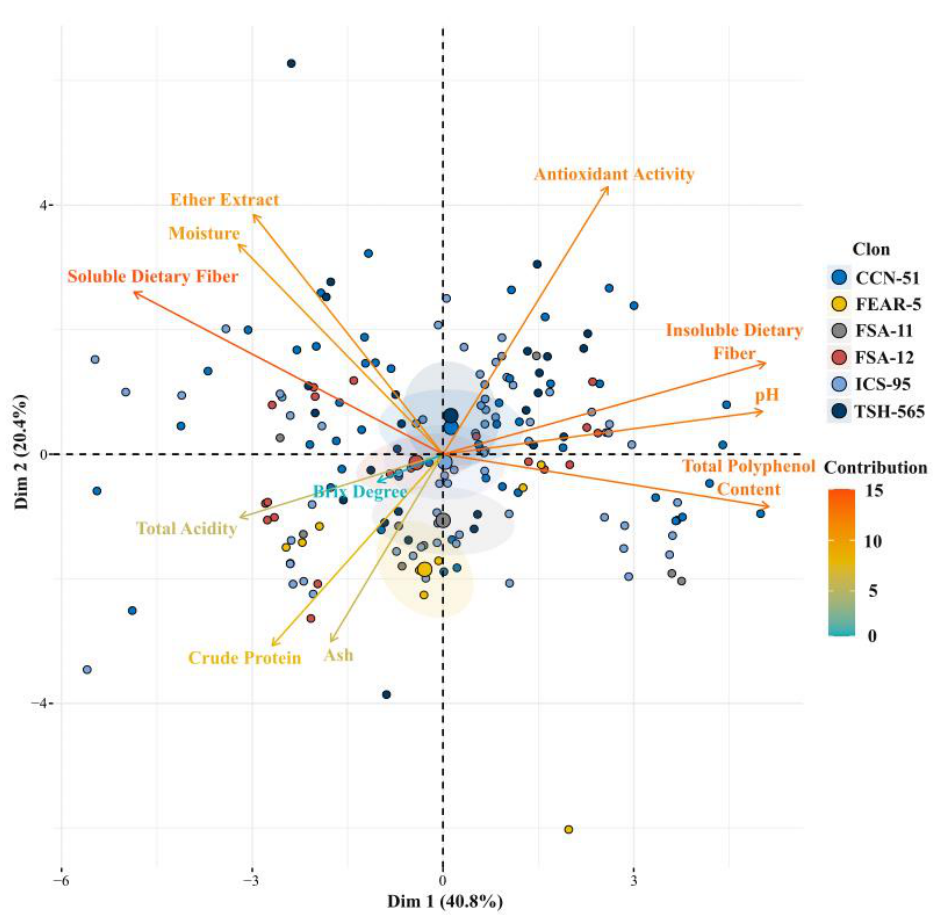
Figure 2. Principal component analysis for the physicochemical variables in relation to the clones evaluated in the department of Meta (Colombia). The color of each variable shows the level of contribution in each component, where green and red are higher to lower contribution.